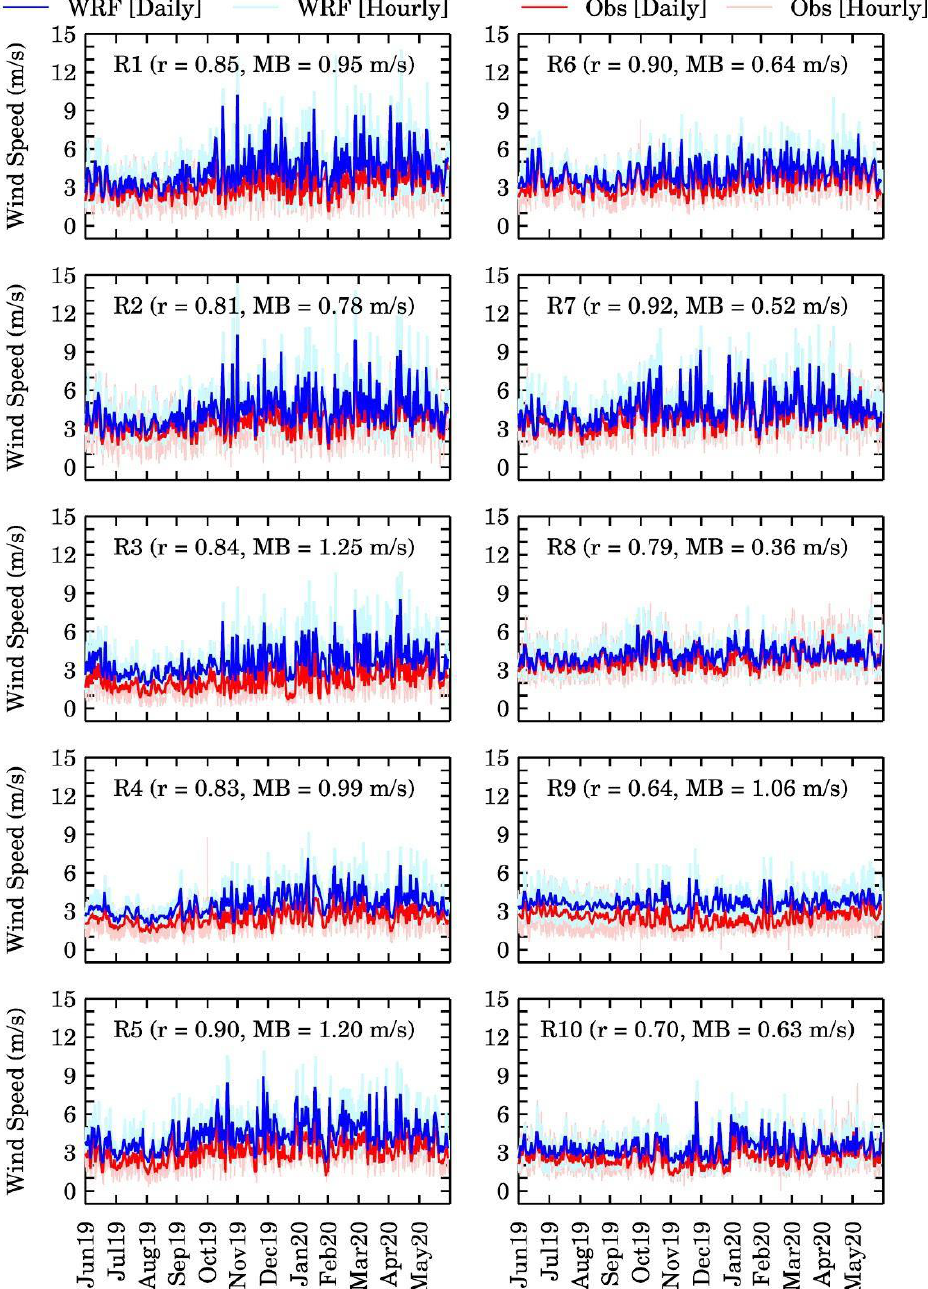
Figure 8. Seasonal variations in hourly and daily observed and model-simulated 10 m wind speed in 10 EPA regions during June 2019 to May 2020. r and MB for each region estimated using paired data for the full year are also shown.